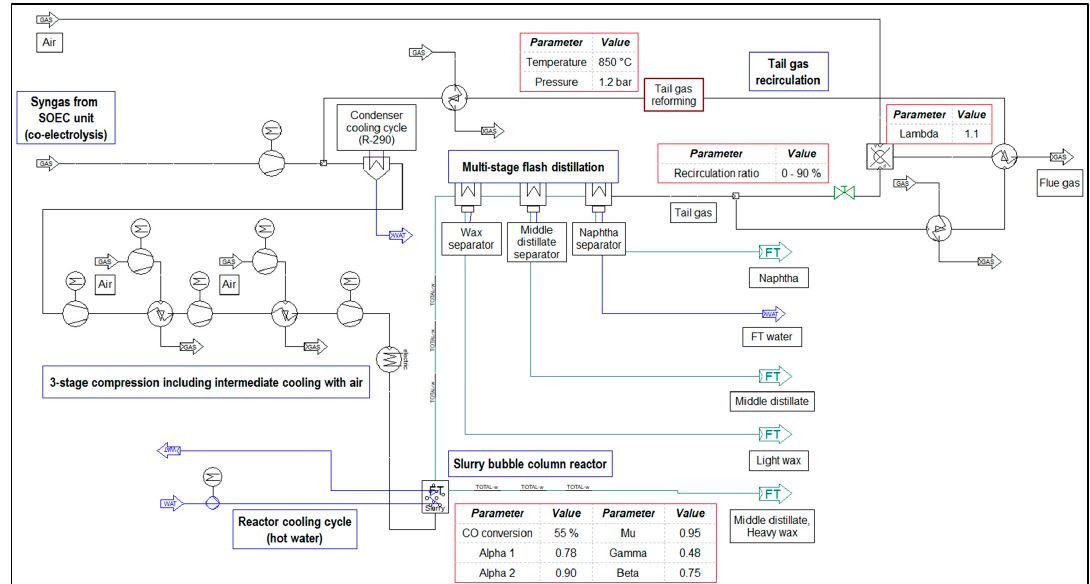
Figure 3. Implementation in IPSEpro—process configuration without tail gas reforming.